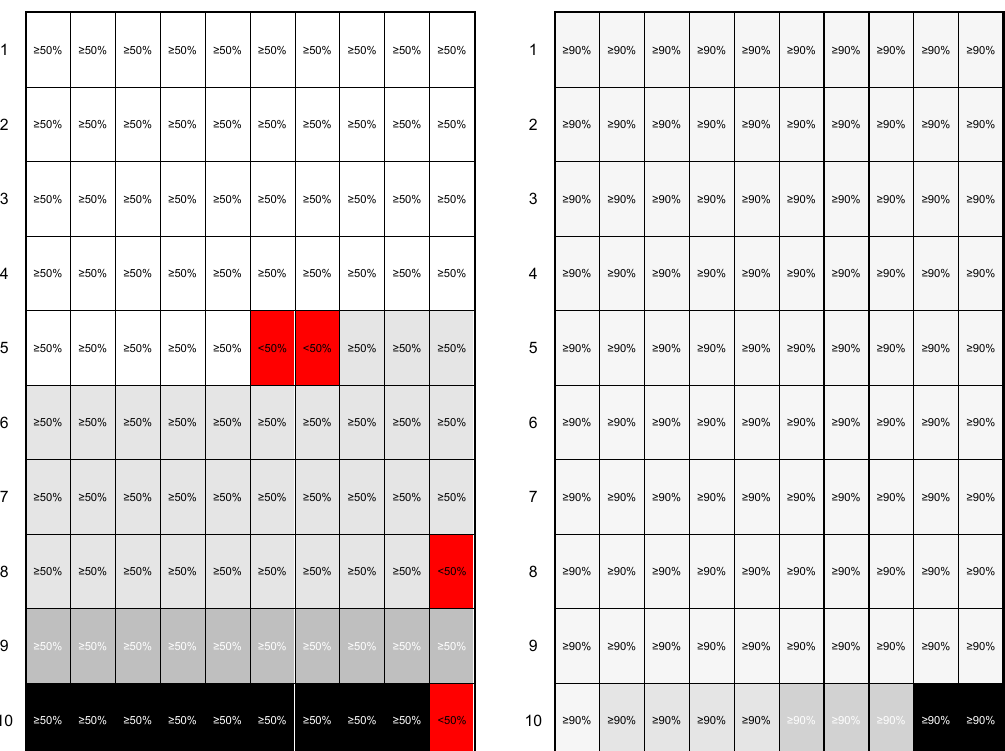
Figure 4. Principle of the introduced image patch and case quality control (QC). To demonstrate the general principle of the introduced QC, two examples—one for 50%/50% image patch/case QC ( A ) and one for 90%/90% image patch/case QC ( B )—are shown. Given the rationale that a patient case would consist of 100 image patches, 50 and 90 image patches would need a probability of at least 50% ( A ) and 90% ( B ) to fall in a class. In the first example ( A ), 96 image patches have a ≥ 50% probability to belong to one class (image QC passed in 96 image patches (different shades of grey correspond to the four classes) and failed in four image patches (red)). As <50% of image patches belong to the class with the largest proportion (light grey), the case QC failed. In the second example ( B ) all image patches have a ≥ 90% probability to belong to one class (image QC passed in all image patches). As >90% of image patches belong to the class with the largest proportion (light grey), the case QC passed. First, the image patch QC was increased from 50% to 90% in 10% increments. With increasing values for the image patch QC, the number of image patches that did not pass the QC increased from 1/2448 (<1%) at an image patch QC of 50% to 386/2448 (16%) at an image patch QC of 90%. Simultaneously, the classification accuracy increased from 89% to 95% in the whole cohort. Most misclassifications were found between ADC and SqCC (Table A1).